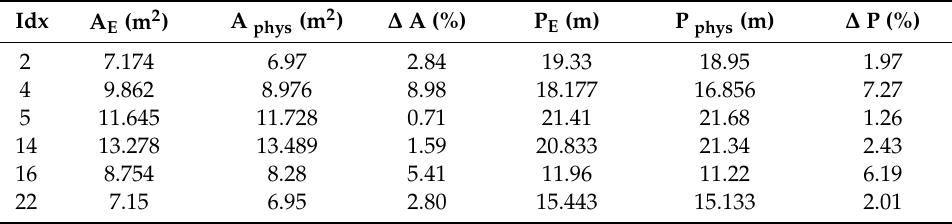
Table 5. Physical area and perimeter, di ff erence in percent